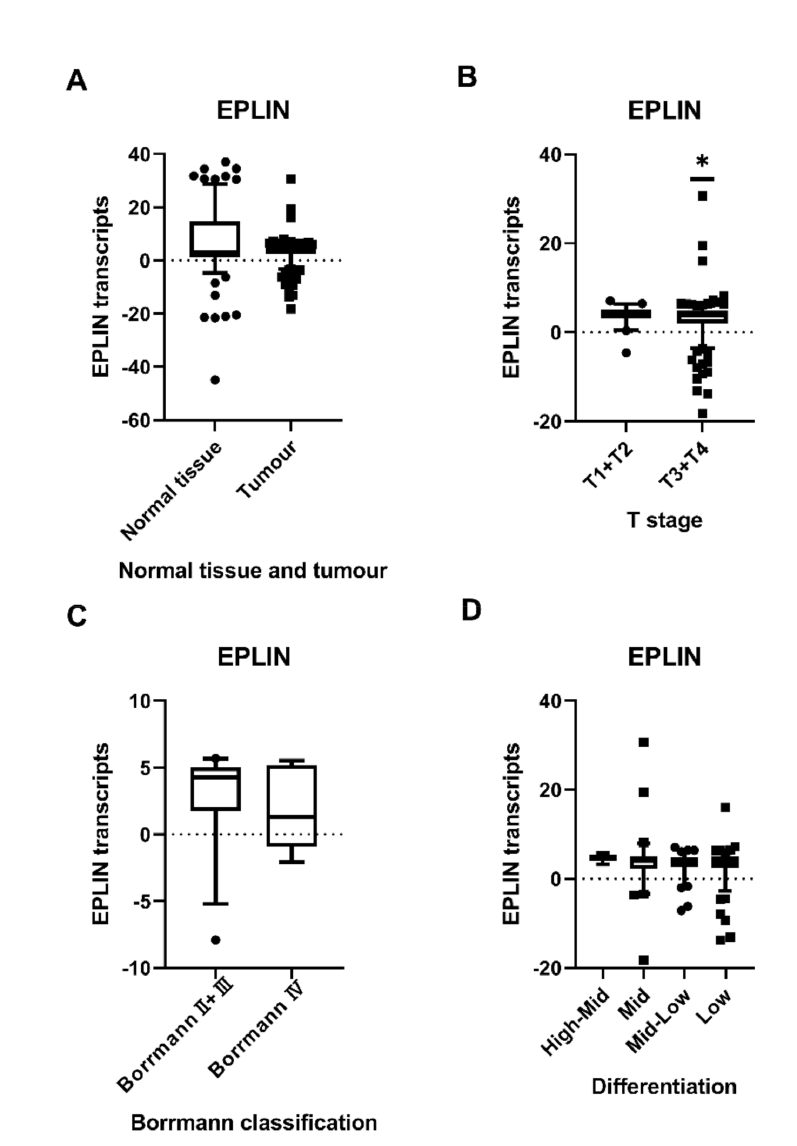
Figure 1. Association between EPLIN expression and T stage, Borrmann classification and differenti- ation in gastric cancer. ( A ): No difference was noted in EPLIN expression between tumour tissues and normal tissues. ( B ): The combined T1 + T2 group had significantly higher EPLIN expression than combined T3 + T4 group. ( C ): The combined BorrmannII + BorrmannIII group had higher EPLIN transcript expression compared to BorrmannIV group. ( D ): There was a decline in EPLIN expression from high-middle differentiation to low differentiation. High differentiation group was not shown because of low sample number. Shown as median log 10 values with 95% cl. * p <